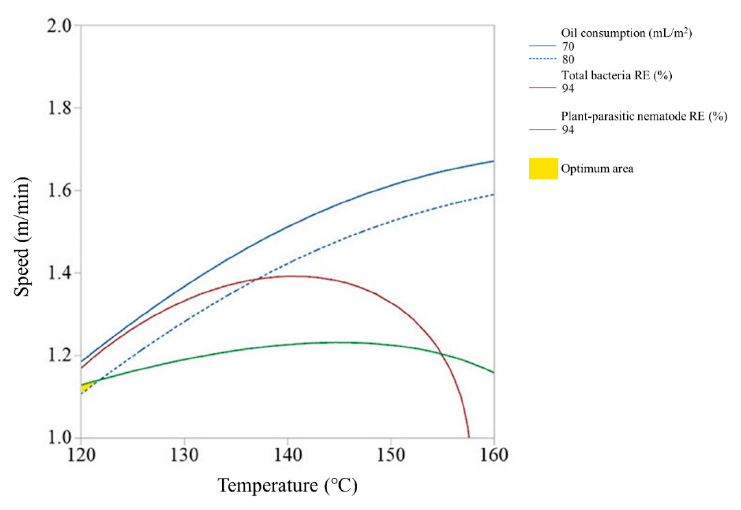
Figure 5. Overlay plot of the steam temperature and running speed on the response variables when the spray depth is 9 cm.